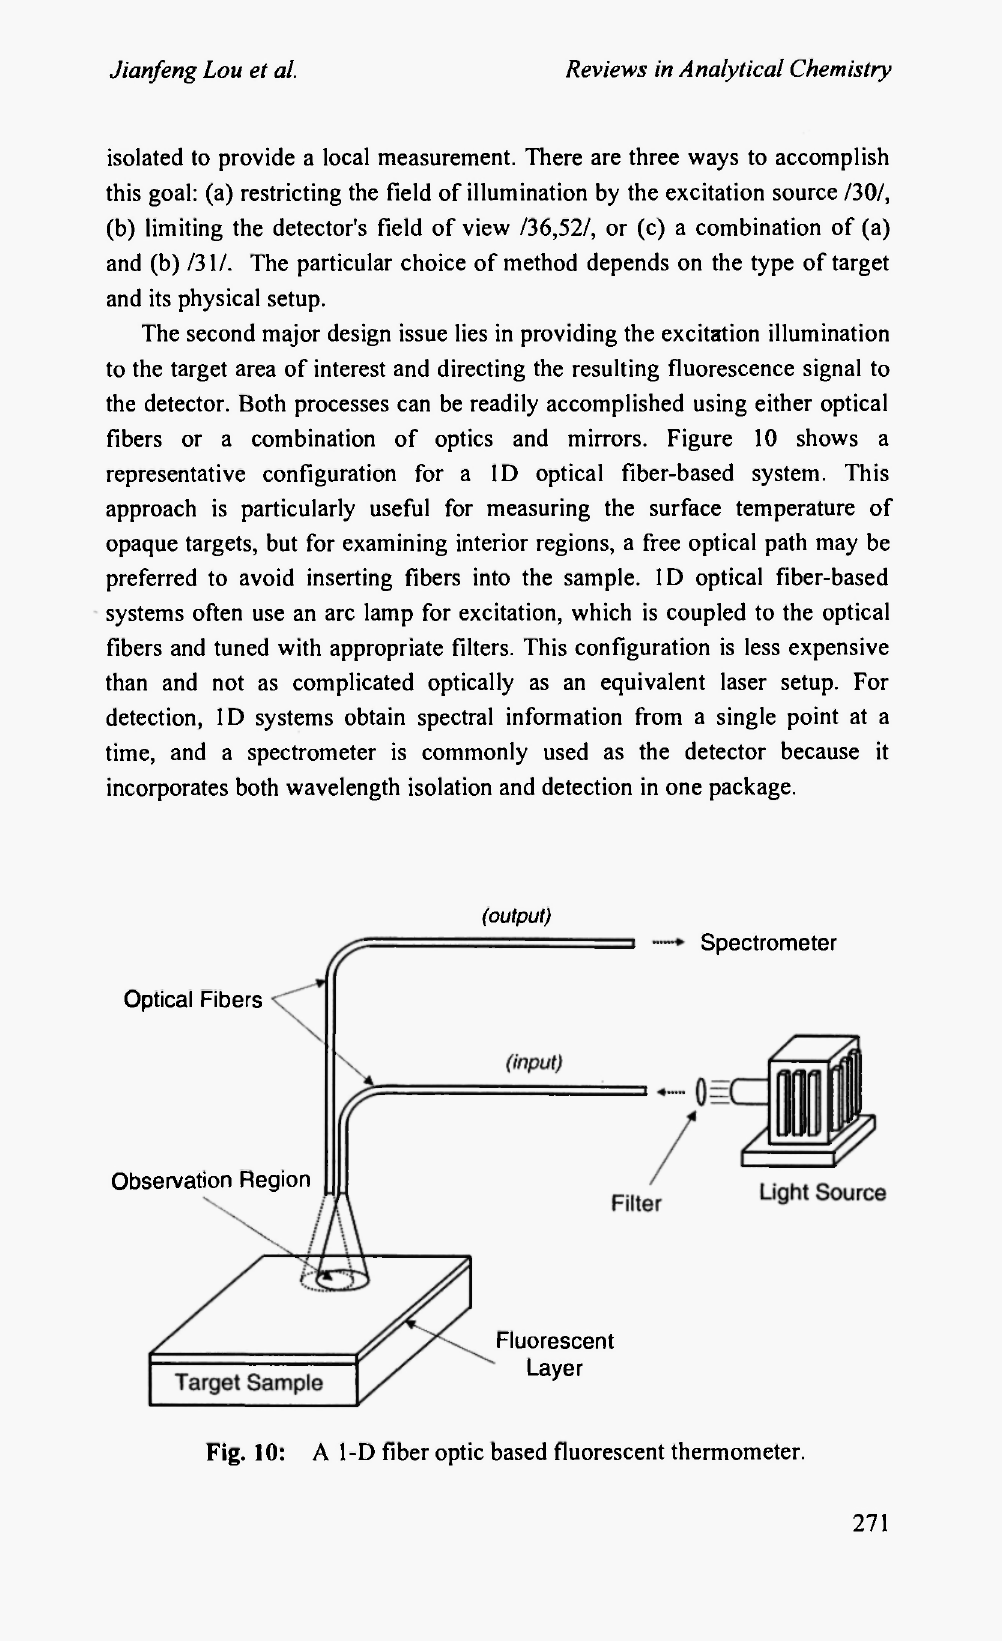
Fig. 10: A 1-D fiber optic based fluorescent